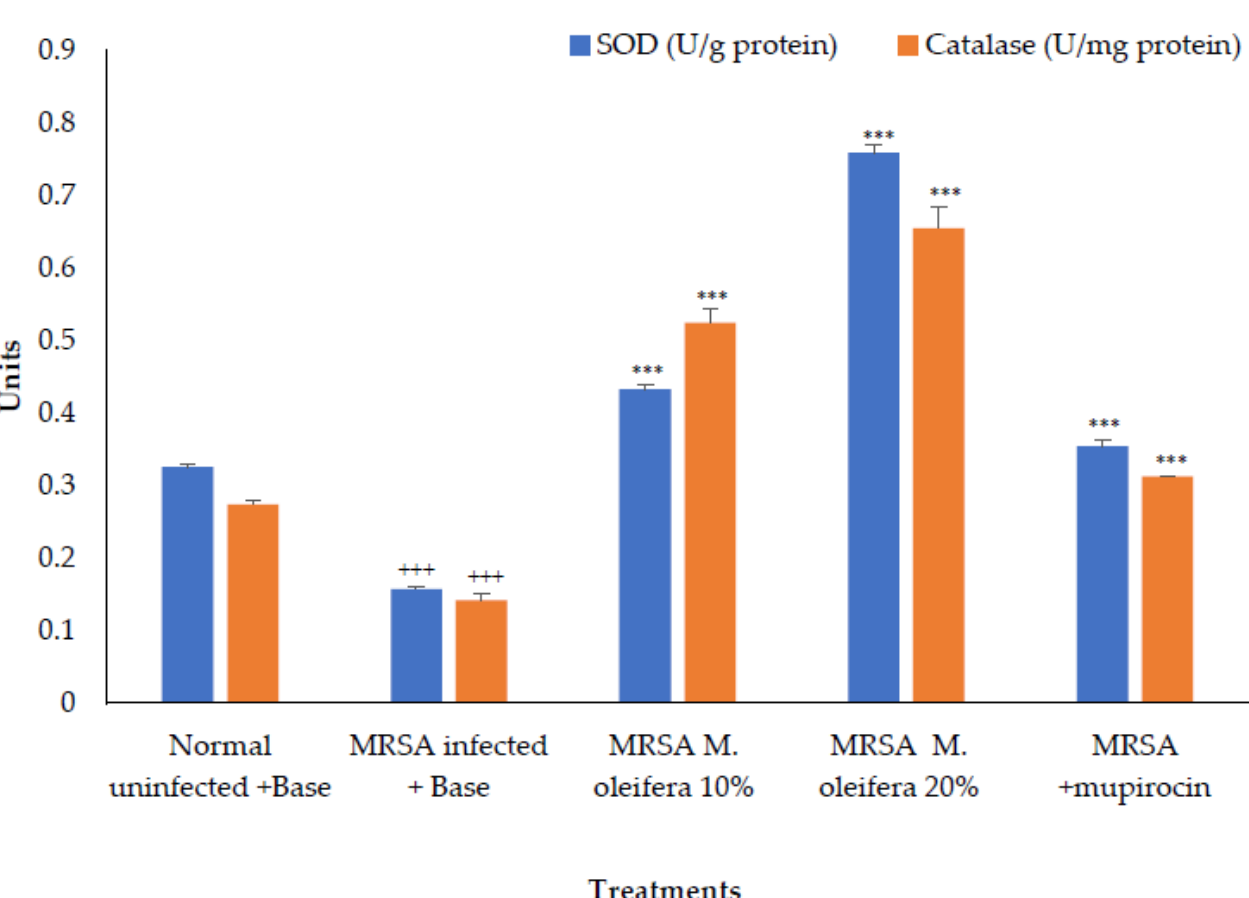
Figure 6. Effect on antioxidant enzymes in MRSA-infected wound tissues of rats. All values are mean ± SEM, n = 6, +++ p < 0.01, *** p < 0.001 when compared to control.